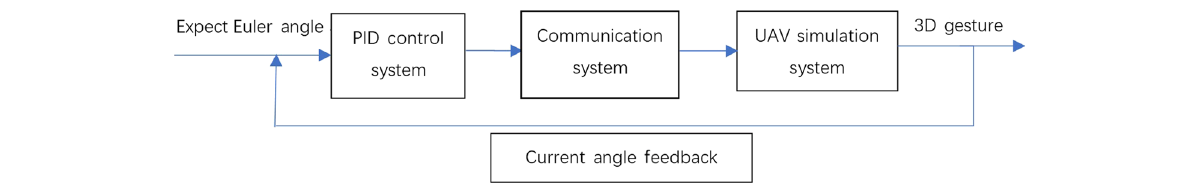
Fig. 1 Proportional-integral-derivative control schematic diagram